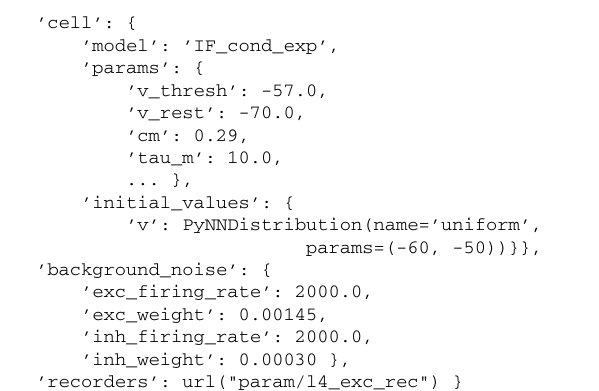
FIGURE 3 | The architecture of the model presented in section 4. The model consists of two thalamic layers, corresponding to ON and OFF cell types (C) , and a single cortical layer of excitatory and inhibitory cells, whose afferent receptive fields are generated drawn from a Gabor-shaped probabilistic distribution, whose parameters are based on an orientation map (B) . The connectivity between cortical neurons is set to have push-pull connectivity, i.e., excitatory neurons selective to a certain orientation and phase connect with a higher likelihood to other excitatory or inhibitory neurons preferring the same orientation and phase, while inhibitory neurons are more likely to connect to excitatory and inhibitory cells preferring the same orientation but opposite phase (A)